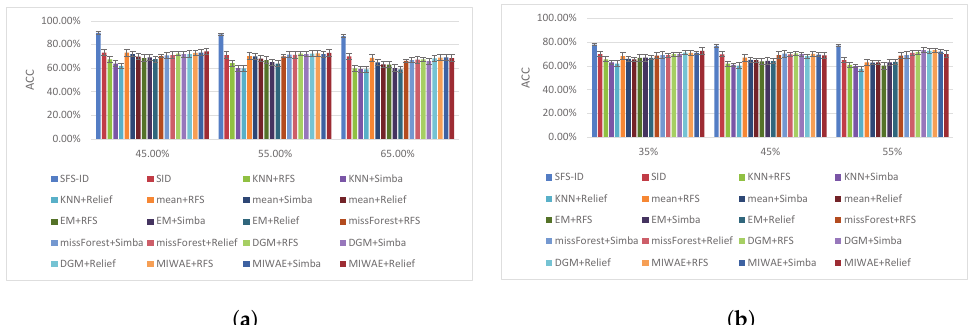
Figure 6. Accuracy under different missing ratios for Splice and Wpbc datasets. ( a ) Splice. ( b ) Wpbc.